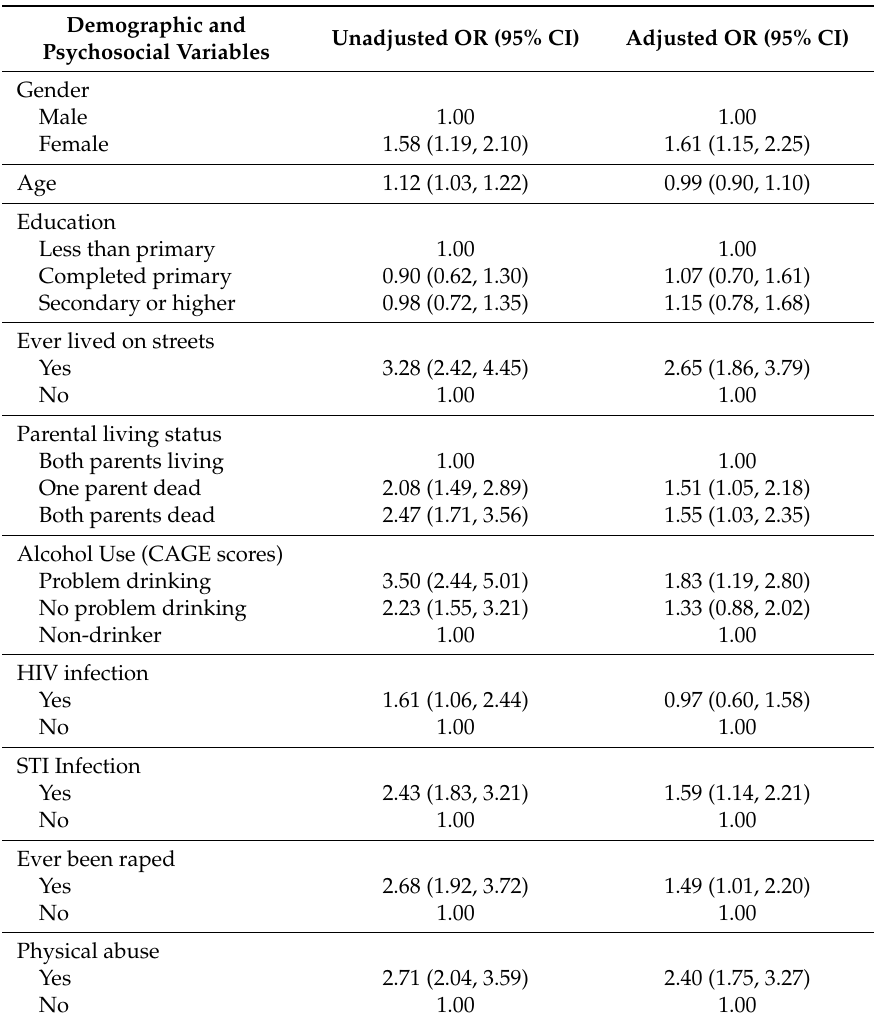
Table 2. Demographic and psychosocial characteristics associated with suicidal ideation among youth living in the Slums of